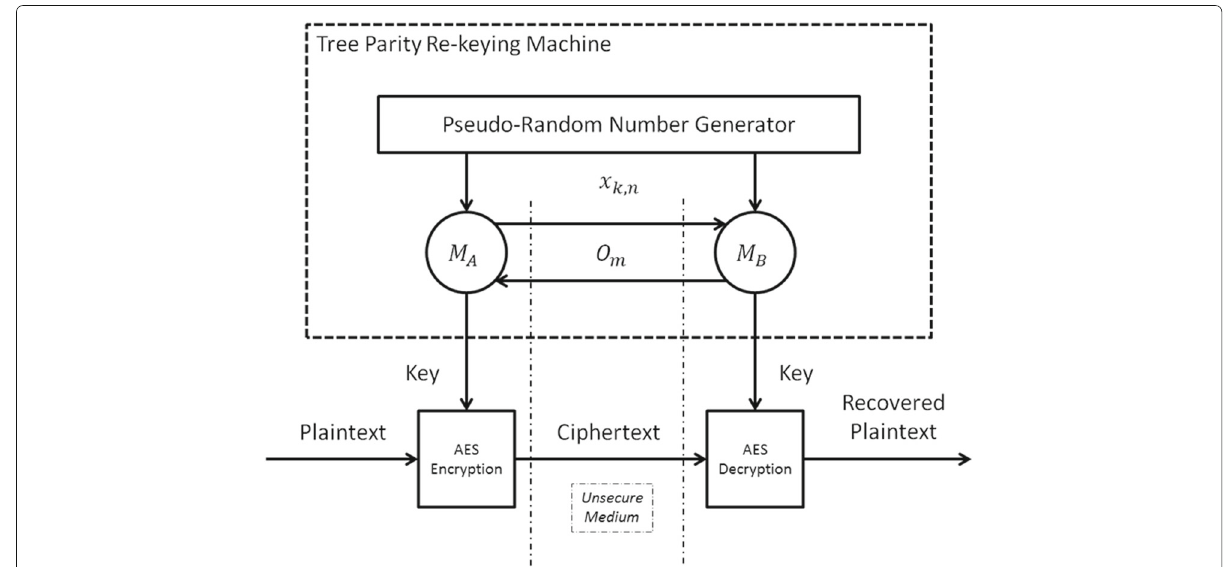
Fig. 2 TPM-AES cryptosystem. An implementation of a TPM and AES hybrid cryptosystem is shown. The PRNG can be generated publicly or privately for each machine